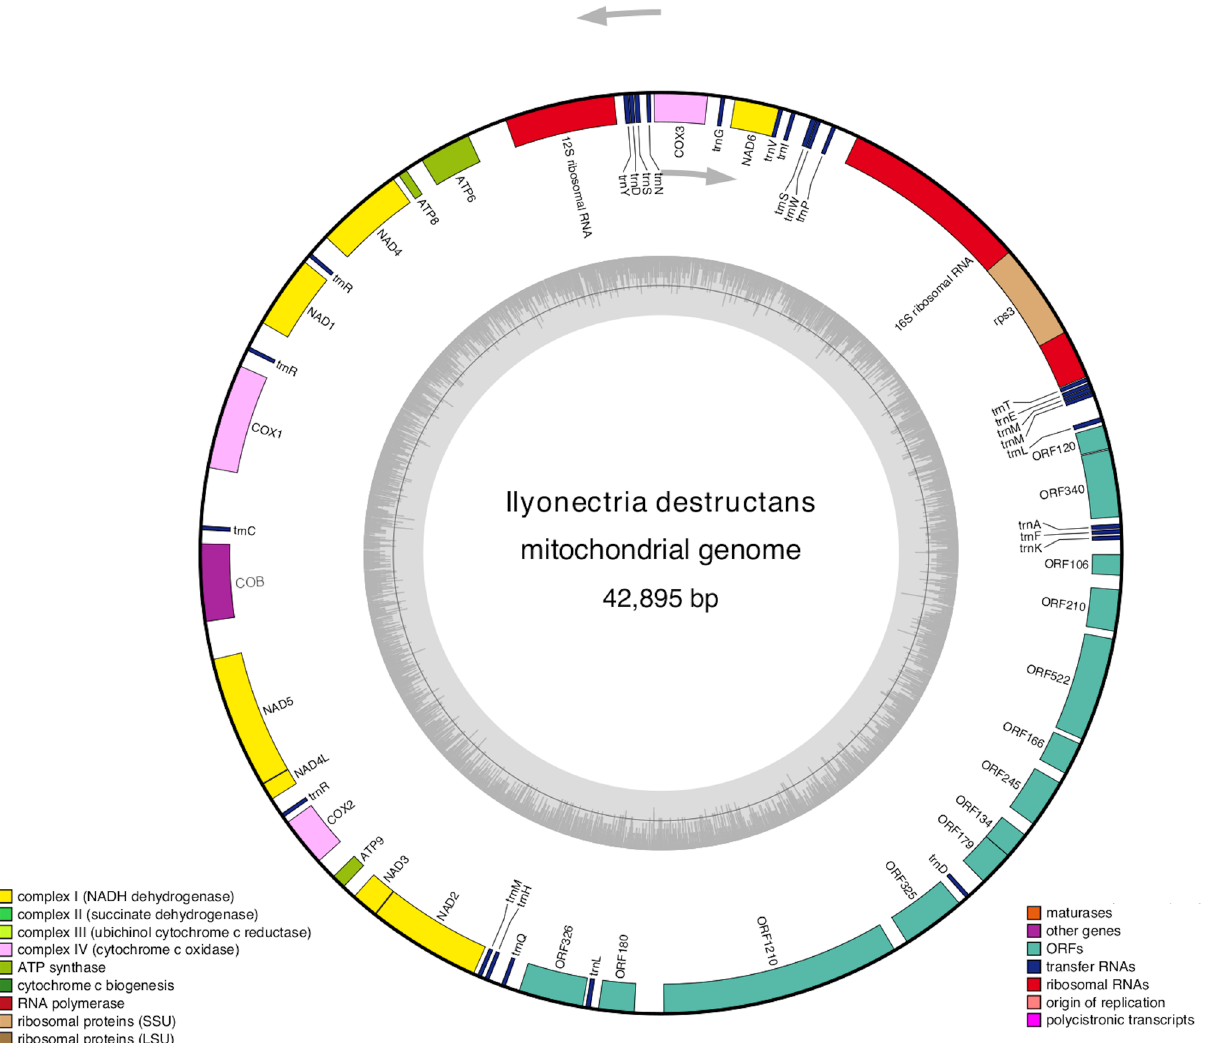
Figure 1. Circular map of the mitochondrial genome of Ilyonectria destructans . Different functional gene groups are color-coded. Genes drawn inside the circle are transcribed clockwise (indicated by arrow). GC content variations is shown in the middle circle. Gene map was generated with the OrganellarGenomeDRAW (OGDRAW) 1.3.1. (https:// chlor obox. mpimp- golm. mpg. de/ OGDraw. protein-coding genes and ORFs, indicated that the most frequently used codons in I. destructans mitogenome were TAA (8.83% for lysine), AAT (6.14% for N), ATA (6.10% for I), TTT (5.00% for F), AAA (4.91% for K) and TAT (4.66% for Y) (Fig. 2, Supplementary Table S1). These six codons accounted for almost 36% of all codons, which contributed to the high AT content (71.77%) of the I. destructans mitochondrial genome. Repeated elements. REPuter software was used to identify 28 repetitive sequences with lengths ranging from 30 to 98 bp and sequence identities greater than 90% (Supplementary Table S2a) within the I. destructans mitochondrial genome. Most of the identified repeated sequences represented forward repeats (18), whereas palindromic (7) and reverse (2) repeats were in the minority, and complement repeats were not detected. Most of the repeat sizes were between 30 and 35 bp (85.7%), followed by 45–57 bp (10.7%) with one 98 bp repeat (3.6%). The repetitive sequences were unevenly distributed, mostly (78.6%) within intergenic regions of the mitogenome, while the remaining 12.4% were located in the sequences coding tRNA. The pattern of repeat sequences within the I. destructans mitochondrial genome was compared with the rate of repeats estimated for unidentified Ilyonectria species whose complete sequence of mitogenome is accessible at an NCBI server under the accession number MH924828. In that case, 13 repetitive sequences with lengths ranging from 30 to 34 bp and sequence identities greater than 90% were found. Only two types of repeated sequences were identified: 11 forward repeats and two palindromic repeats, which were located almost exclusively within the intergenic regions of the mitogenome (Supplementary Table S2b). The distribution and types of microsatellites were also studied in the I. destructans mitochondrial genome. Generally, the I. destructans mitogenome appeared as rather poor in terms of SSR content, as only 14 of such